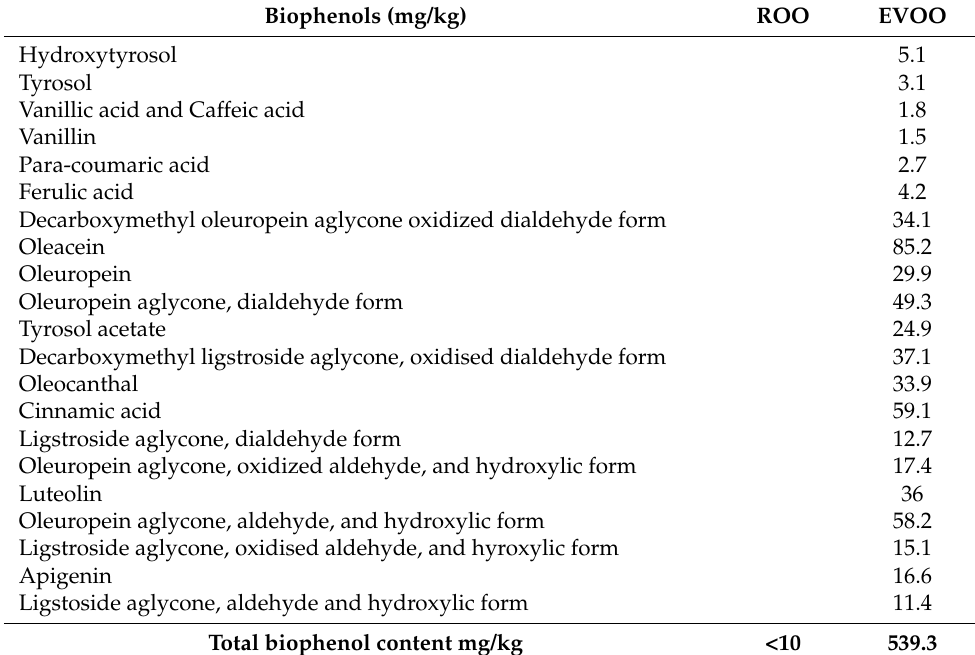
Table 2. Phenolic compounds and their concentrations present in